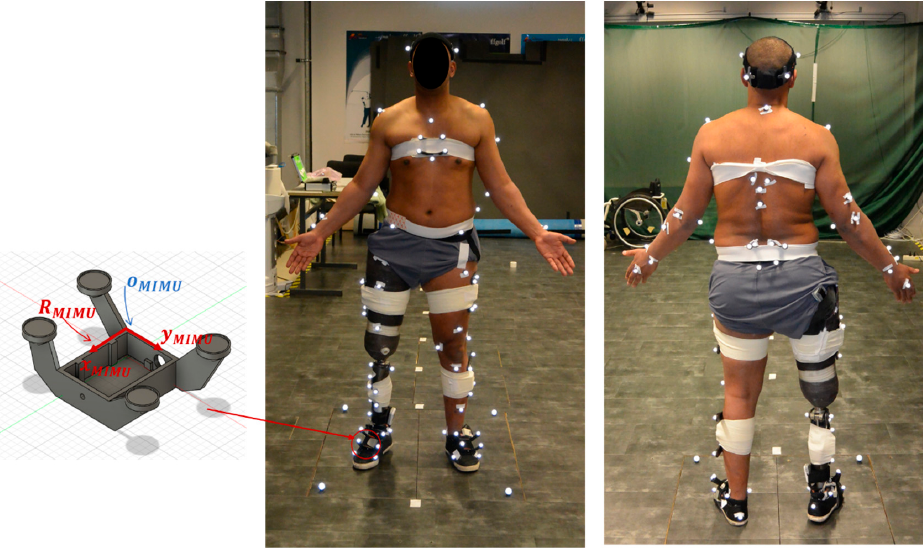
Figure 3. Full-body marker set and custom 3D-printed plastic MIMU